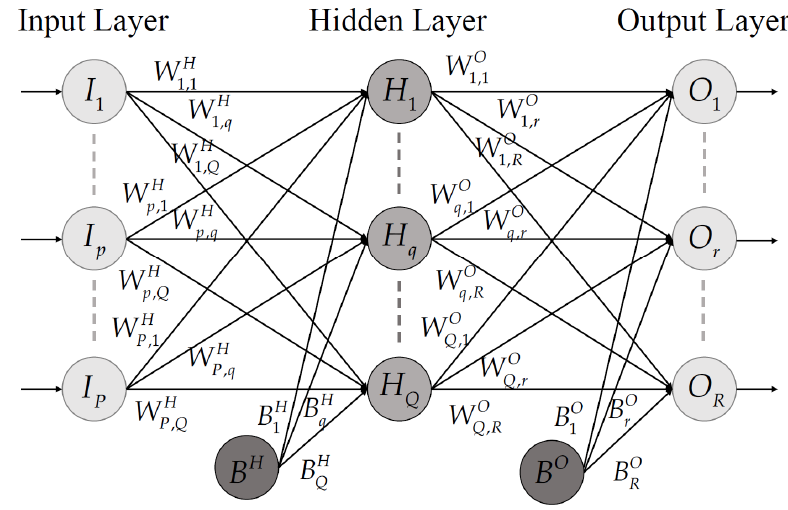
Figure 1. The network architecture of an ANN model with three-layer structure. Table 2. The mathematical formulation of the considered activation functions Activation Functions